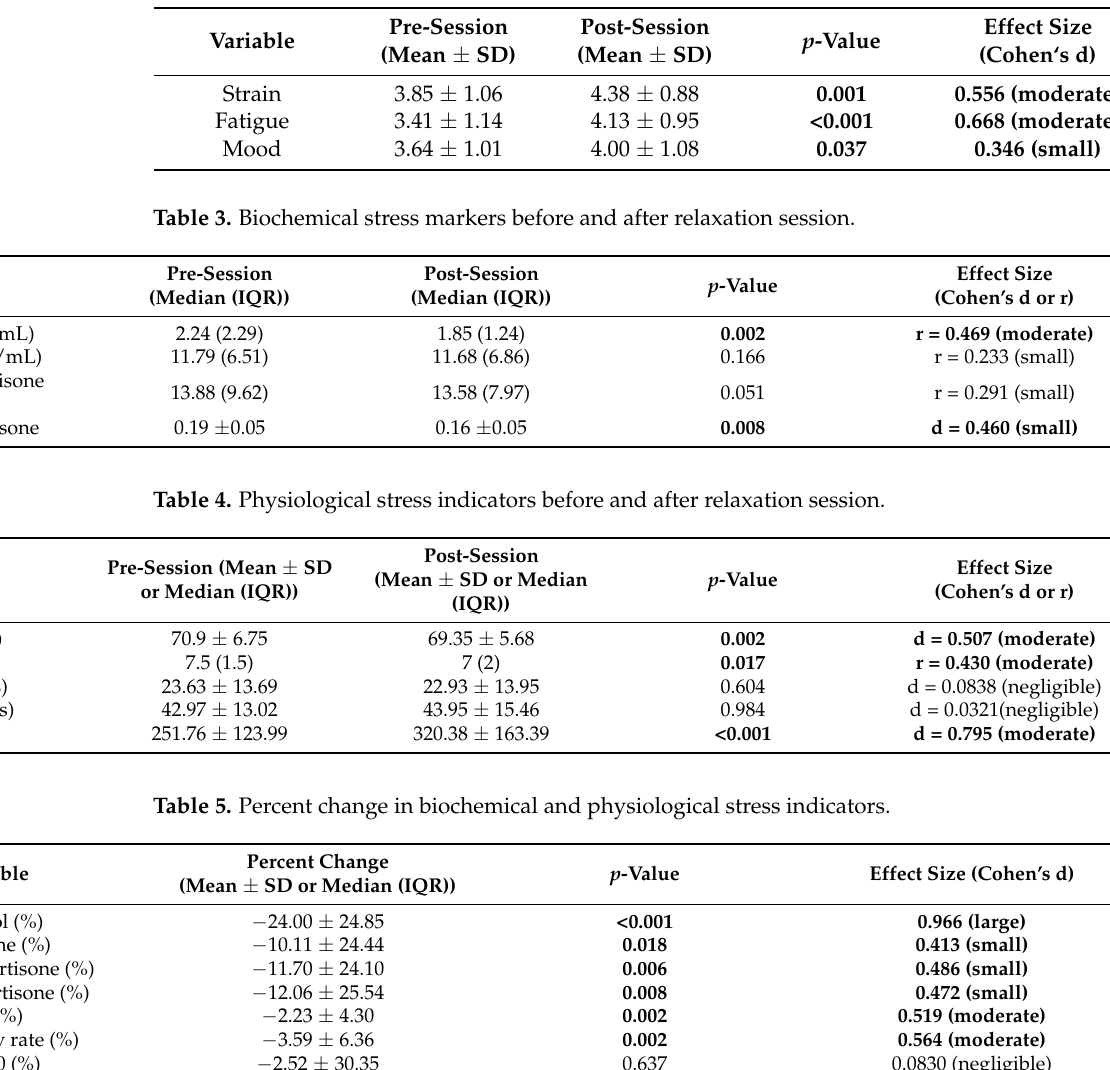
Table 2. Psychological stress indicators before and after relaxation session.